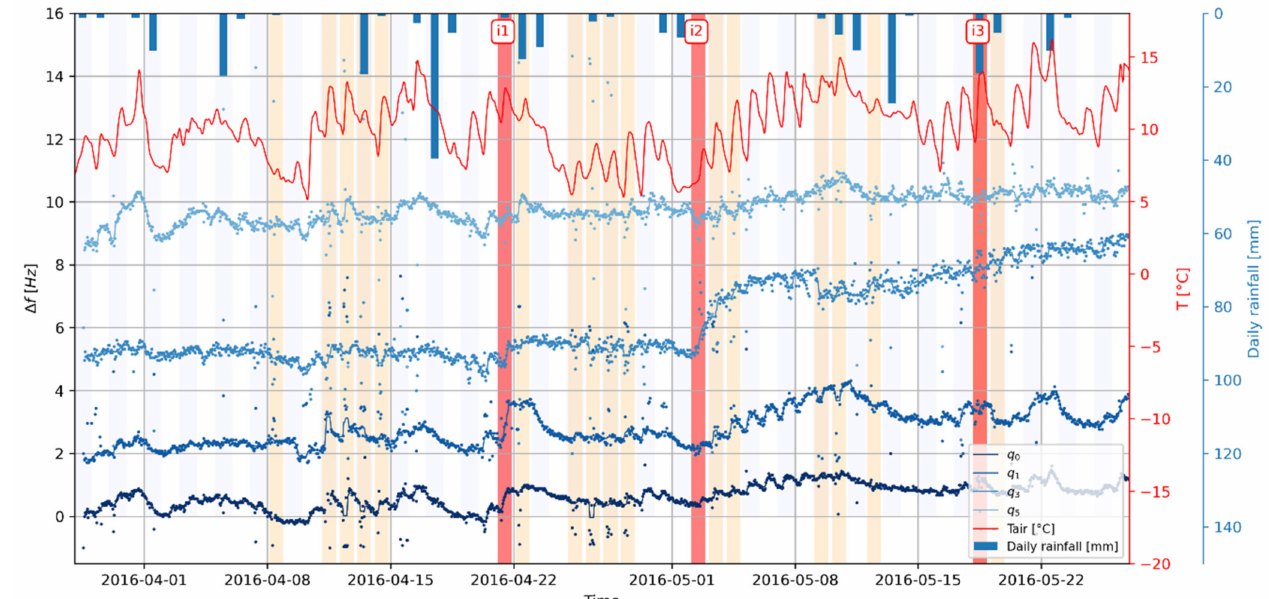
Figure 8. Variations in HHSR peak frequencies q 0 – q 5 over with time (frequencies have been arbitrarily shifted for the sake of easier comparison). Continuous lines show the rolling median computed on 12 h long windows. Air temperature on-site is shown as red curve, and daily rainfall is shown as blue bars (downward axis). Reinforcement work stages are shown in the background: drilling days (light orange) and grout injection (red).